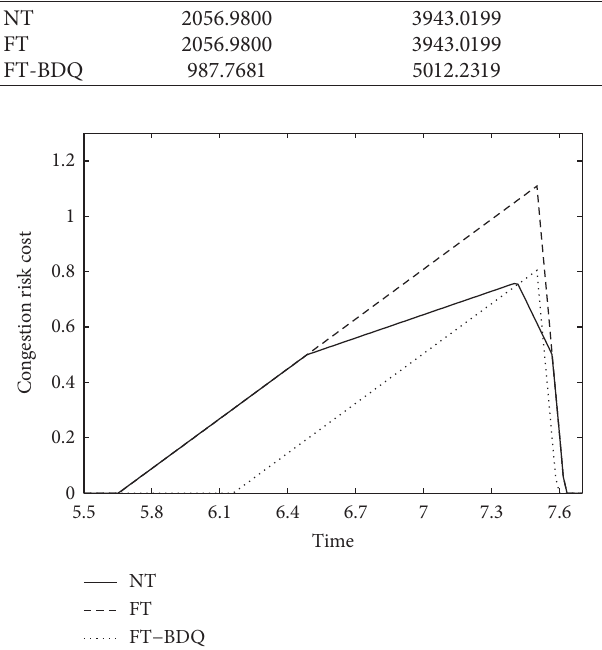
Figure 1: Congestion risk cost of bus travel under three schemes.